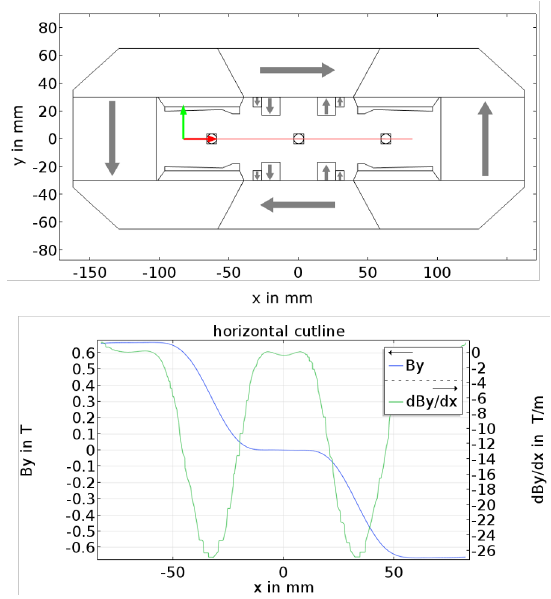
Figure 9. FEM simulation and measurement of COSY kicker magnet model powered with 500A. The upper figure shows the magnetic flux density distribution in the iron yoke of the magnet. The colorplot scale indicates that the magnetic flux density in the iron does not exceed 0 . 45T which is well below saturation. The lower graph shows the simulation and the measurement of the magnetic flux density y-component in the centre of the magnet along the z-axis according to the coordinate system shown in the top figure.